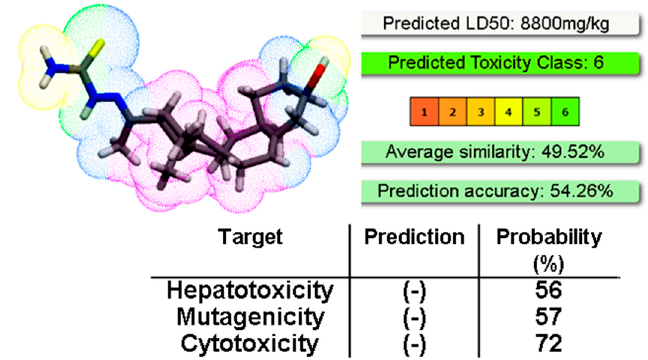
Figure 4. We show the output screen obtained from the open-access toxicity prediction software ProTox-II using compound 8 , (-) indicates no toxicity. The structural similarity of the compound with those in the software database is around 50%.